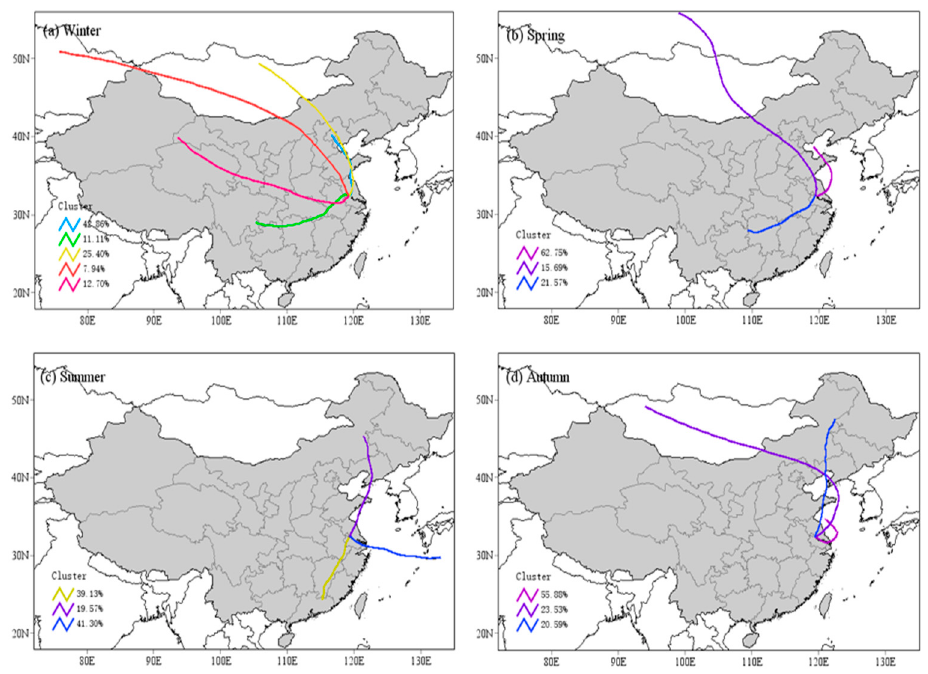
Figure 11. Clusters of the 72-h back trajectories during ( a ) winter, ( b ) spring, ( c ) summer, and ( d ) autumn.